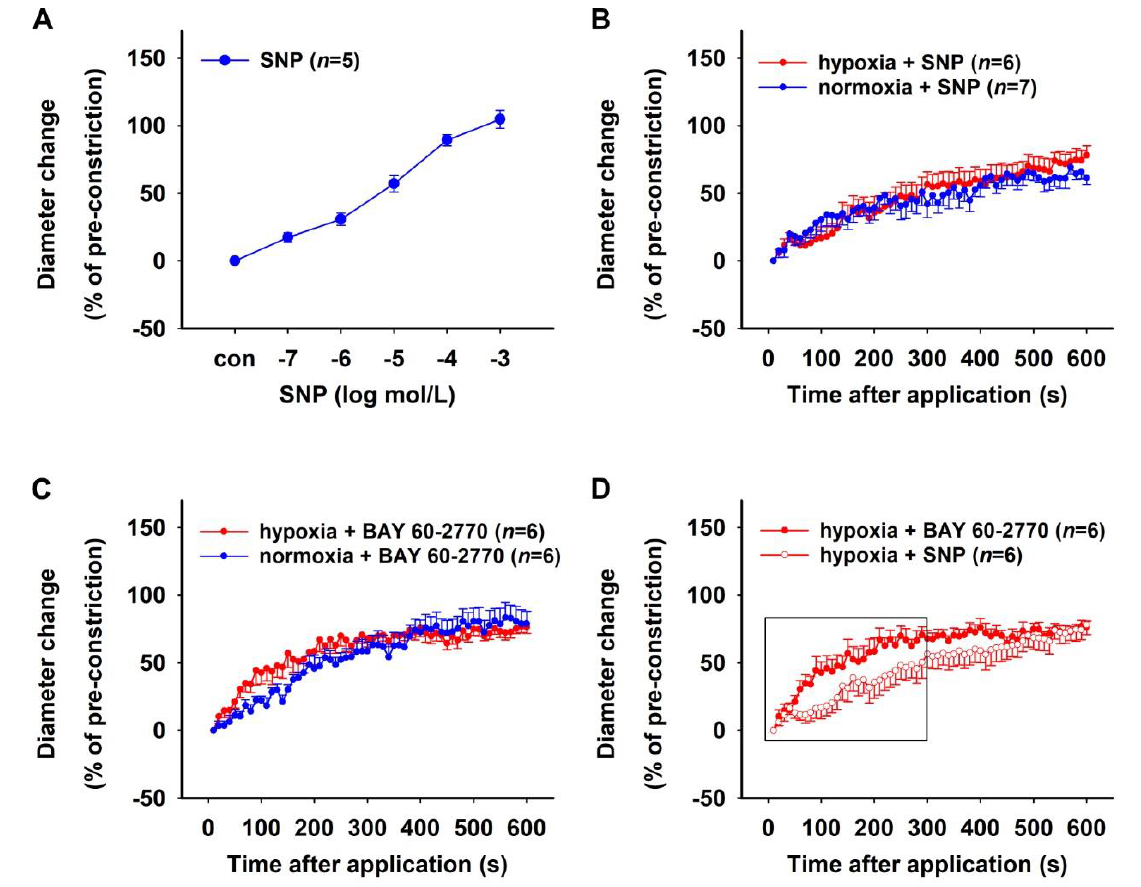
Figure 6. Effects of sodium nitroprusside (SNP) and BAY 60-2770 on hypoxic rat DVR. ( A ) Concentration–response curve showing relaxation induced by 10 − 11 –10 − 5 mol/L sodium nitroprusside (SNP) in rat vasa recta. Vessel diameter did not change under control conditions (con), i.e., in the absence of BAY 60-2770. Time–response curves showing the effect of ( B ) the NO donor SNP (10 −3 mol/L) and ( C ) the NO-independent sGC activator BAY 60-2770 (10 − 6 mol/L) on hypoxic and normoxic vessels over a period of 10 min. Vessels were pre-incubated either in a 0.1% oxygen (O 2 ) atmosphere (hypoxia) or in a 20.9% O 2 atmosphere (normoxia) with 10 − 4 mol/L L-NAME for 30 min followed by a pre-constriction with 10 − 6 mol/L Ang II. Relaxation to SNP and BAY 60-2770 were similar in hypoxic and normoxic vessels, respectively. However, ( D ) hypoxic vessels showed faster relaxation in re- sponse to BAY 60-2770 compared to SNP (Brunner test, p < 0.05, same data as ( B , C )).